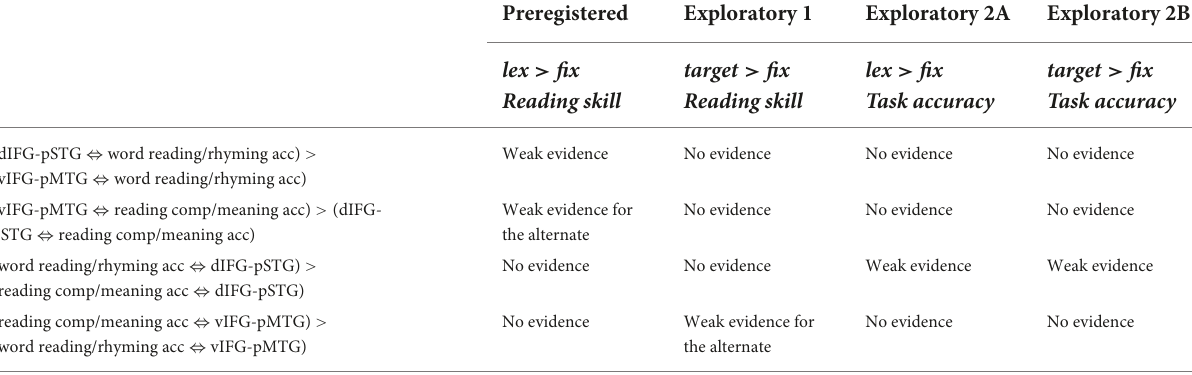
TABLE 3 Summary of results showing strength of evidence for each hypothesis across the pre-registered and exploratory analyses using the lexical > fixation (lex > fix) and target-conditions > fixation (target > fix)